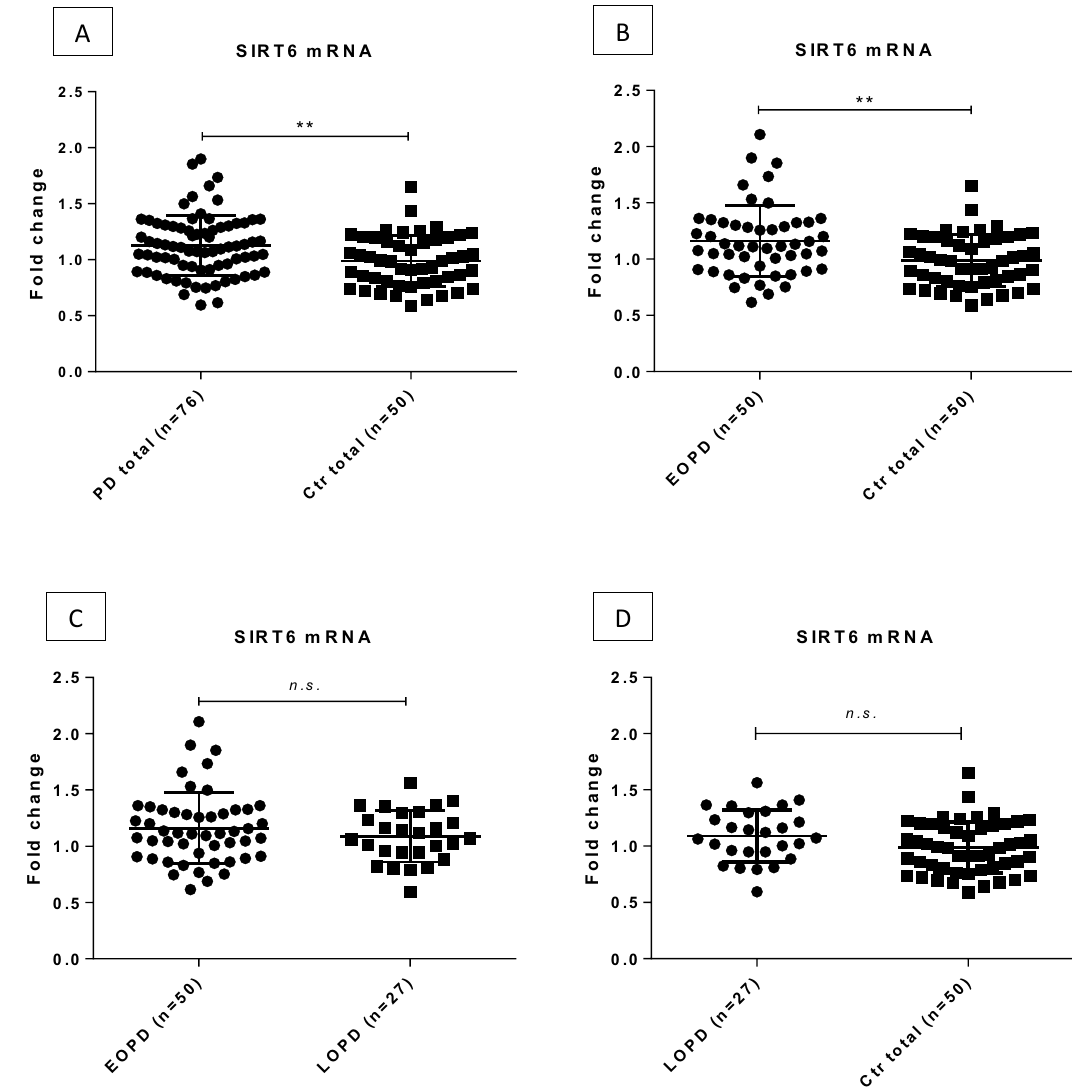
Figure 4. Expression levels of SIRT2 in the peripheral blood of PD patients and healthy controls. The expression level did not shown differences between the investigated groups. Fold changes are shown with standard deviation. PD Parkinson’s disease, Ctrl control, EOPD early onset Parkinson’s disease, LOPD late onset Parkinson’s disease, n.s.